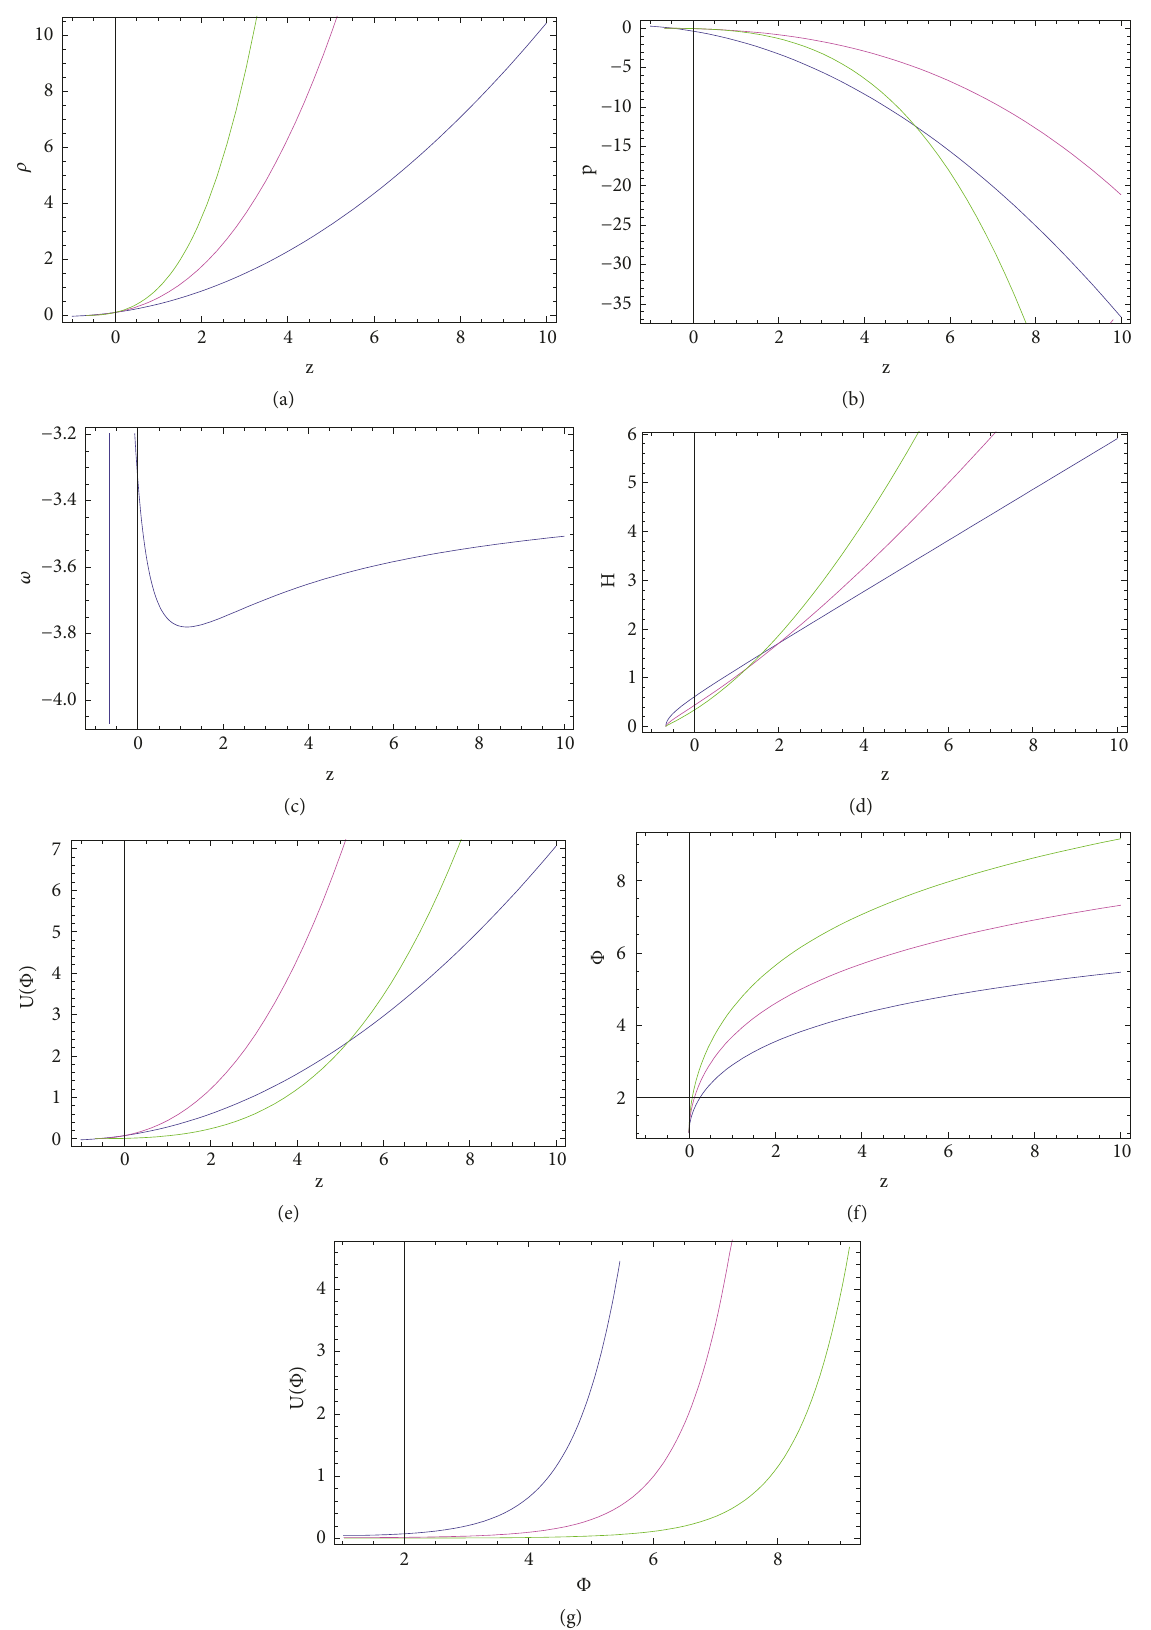
Figure 4: (a), (b), (c), (d), (e), and (f) show the variation of energy density 𝜌 , pressure 𝑝 , EoS parameter 𝜔(𝑧) , Hubble parameter 𝐻 , potential 𝑈(𝜙) , and the scalar field 𝜙 with the variation in 𝑧 for the ASSS parameterizations. (g) shows the variation of 𝑈(𝜙) with 𝜙 . Different colored paths are obtained for different values of